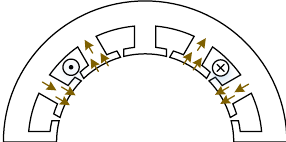
Figure 6. Armature field excited by phase C winding.